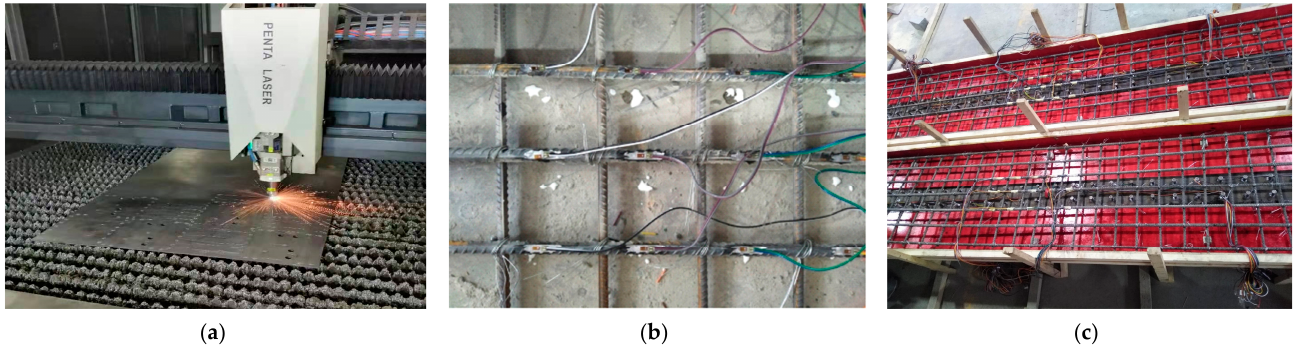
Figure 1. Fabrication of specimens: ( a ) laser cutting; ( b ) strain gauge sticking; ( c ) formwork. Table 1. Design parameters of the specimens.